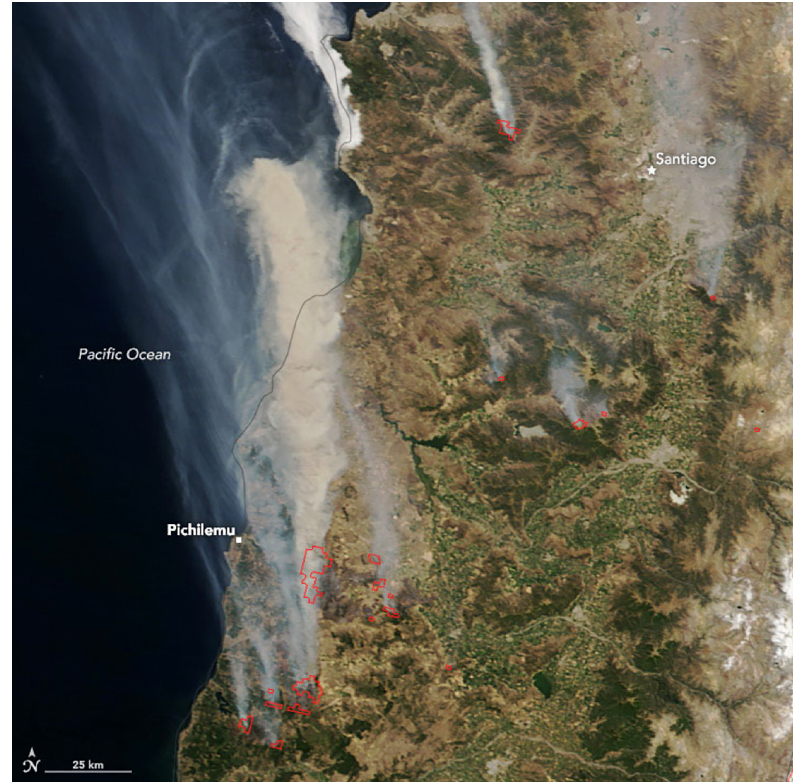
Figure 1. Chile wildfires detected by Terra MODIS on 20 January 2017 (image source: NASA’s Earth Observatory https://earthobservatory. nasa.gov/images/89496, last access: 11 September